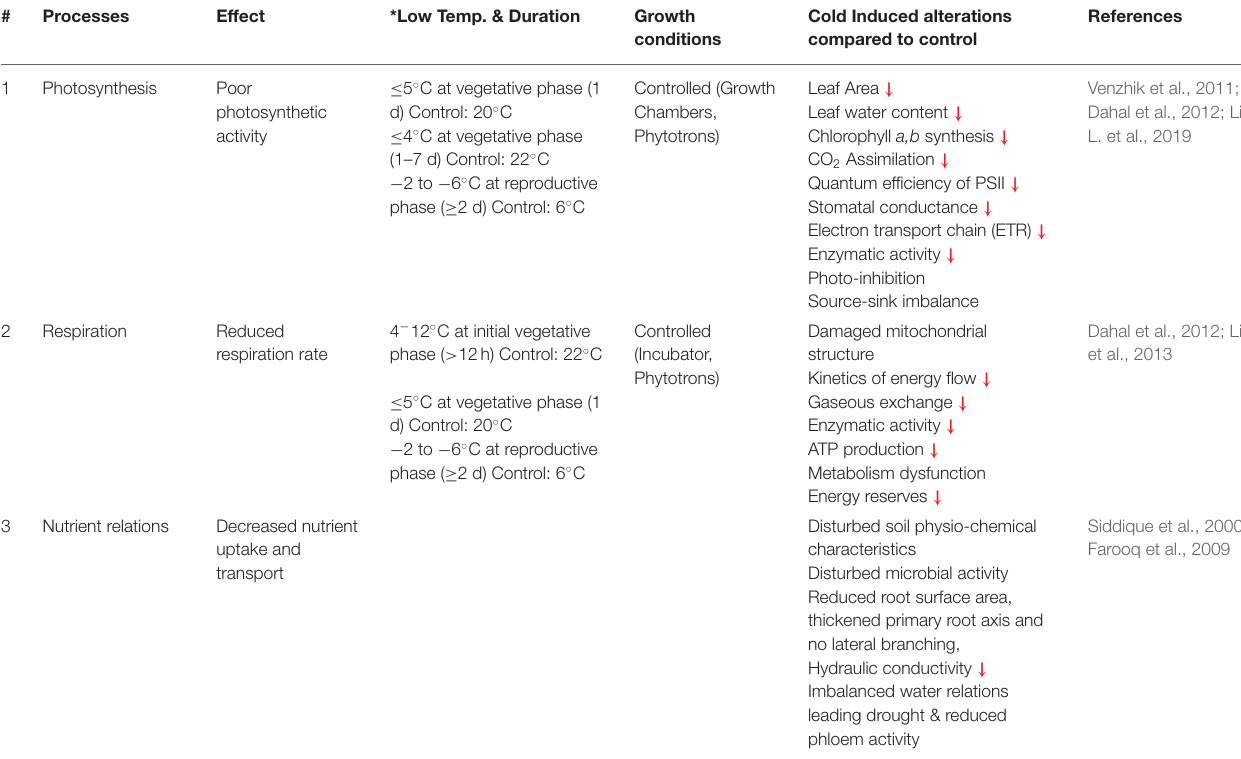
TABLE 3 | Physiological and biochemical traits influenced by cold